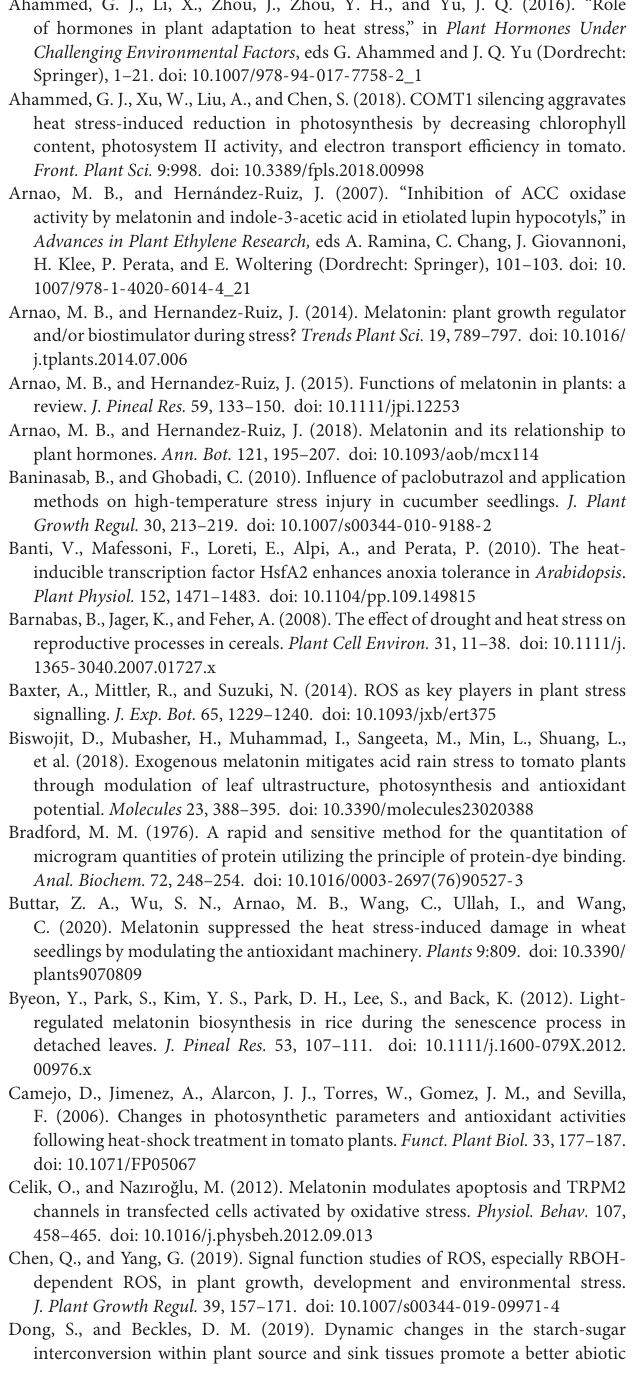
Supplementary Table 13 | Detailed information of the changes in the expression of hormone related genes in Con, ConMT, S, and SMT comparisons. Supplementary Table 14 | Detailed information of the changes in the expression of chlorophyll, flavonoids, and carotenoid metabolic related genes in Con, ConMT, S, and SMT